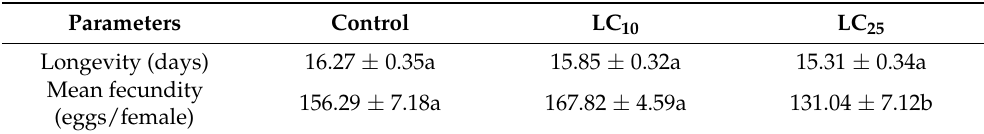
Table 2. The effects of sublethal concentrations of Beauveria bassiana BEdy1 on adult longevity and fecundity of the F 0 generation Sogatella furcifera